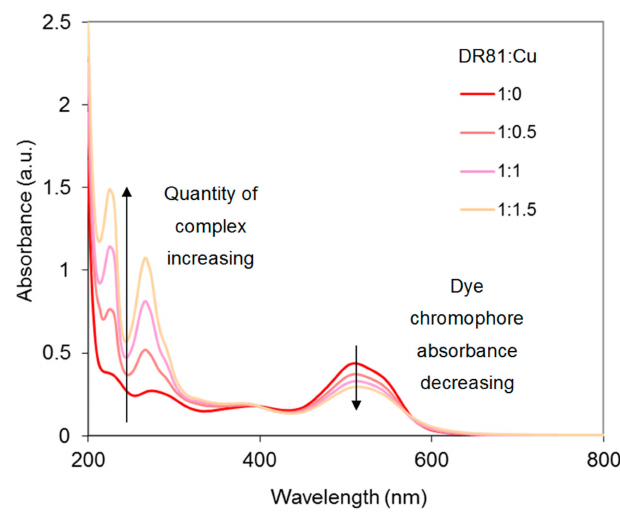
Figure 14. Absorbance spectra of the dye/copper-phenanthroline system at pH 10.7, with Cu:Phen molar ratio = 1:2 and [DR81] = 10 µ M, for different DR81:Cu molar ratios.